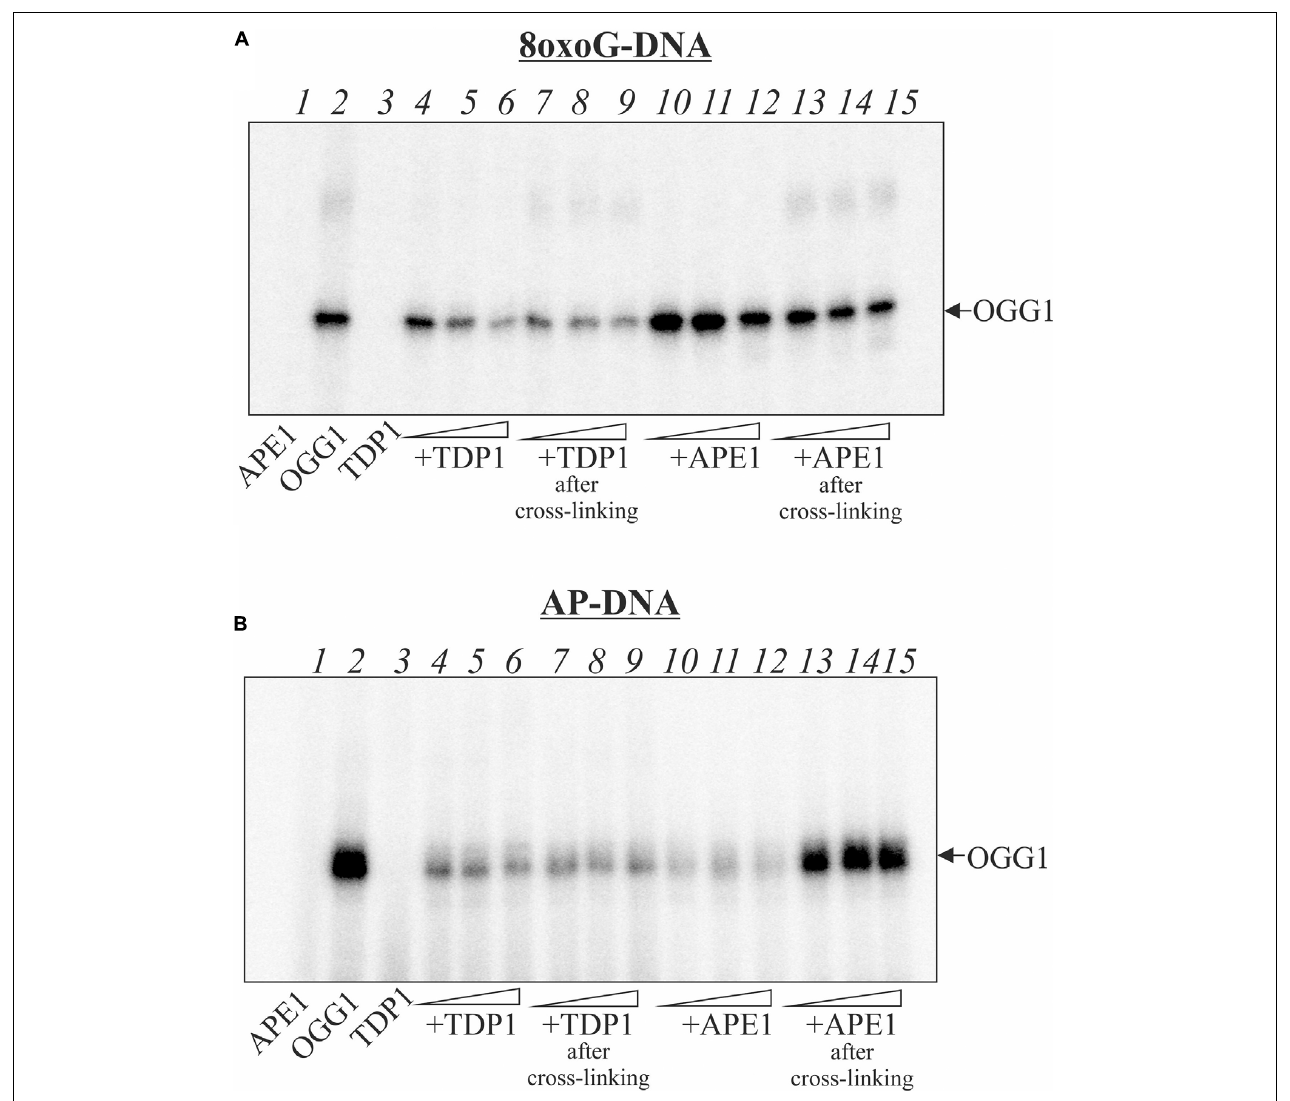
FIGURE 2 | Effect of the order of TDP1 and APE1 addition on the crosslinking of OGG1 to AP site-containing DNA. Phosphorimages of crosslinked proteins to 32 P-labeled 8-oxoG-containing DNA (A) and to AP site-containing DNA after treatment with UDG (B) . Reaction mixture included 10 nM DNA, 50 nM OGG1 and different concentrations (50, 100, and 200 nM) of TDP1 or APE1. TDP1 or APE1 were added to the reaction mixture simultaneously with OGG1 (lanes 4–6 and 10–12) or after incubation of DNA with OGG1 for 10 min (lanes 7–9 and 13–15). Lane 1 in (A,B) represent DNA substrate incubated with 200 nM APE1, lane 2 – DNA substrate incubated with 50 nM OGG1, lane 3 – DNA substrate incubated with 200 nM